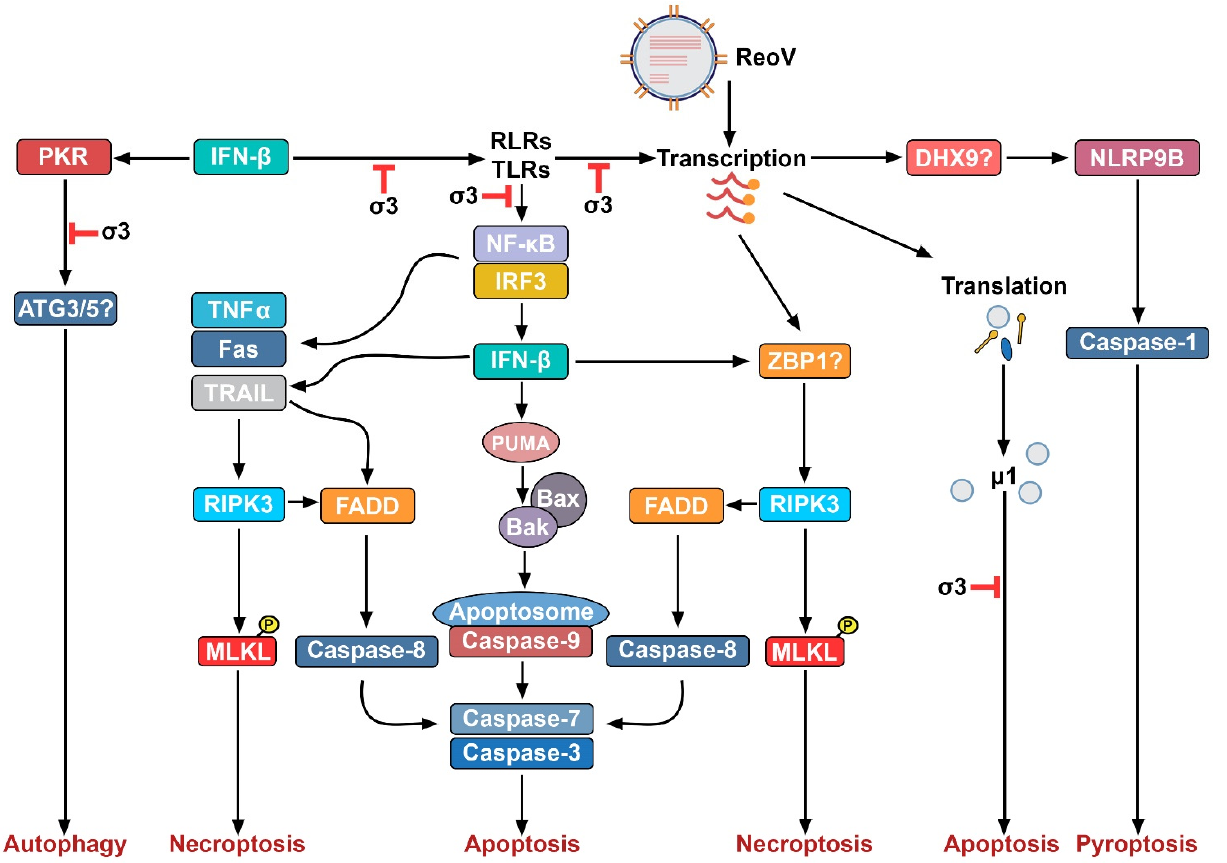
Figure 3. Programmed Cell Death Pathways activated by ReoV. This figure illustrates four potential programmed cell death pathways activated by ReoV infection. Potential dsRNA sensors in these pathways are indicated by question marks.